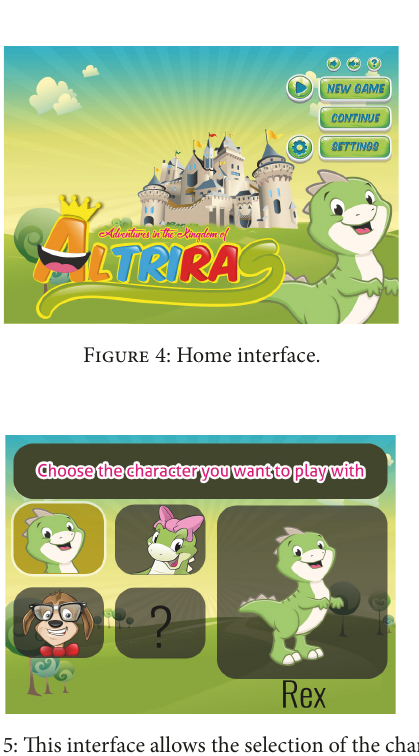
Figure 5: This interface allows the selection of the character.